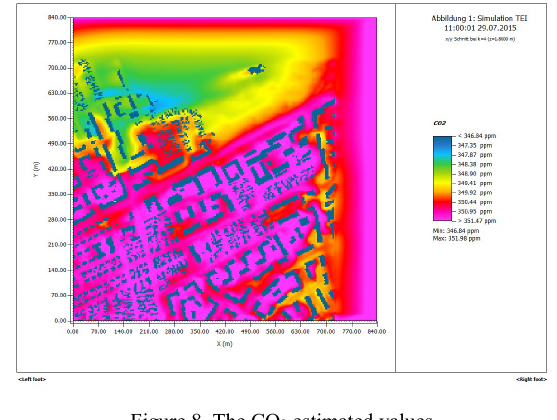
Figure 8. The CO 2 estimated values